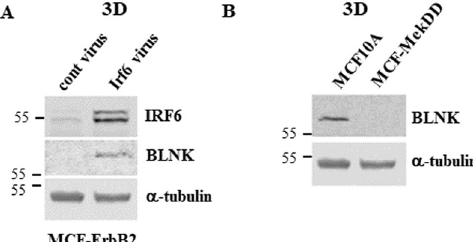
Fig. 2 Irf6 upregulates BLNK in detached ErbB2-positive breast cancer cells. A MCF-ErbB2 cells infected with the control (cont virus) or the Irf6-encoding Maloney murine leukemia virus (MMLV) (Irf6 virus) were cultured detached from the ECM for 24 h and assayed for Irf6 and BLNK levels by western blotting. α -tubulin was used as a loading control. B MCF10A cells and a variant of MCF10A cells obtained by infection of these cells with a retrovirus carrying constitutively active Mek2 mutant (MCF-MekDD) were cultured detached from the ECM for 24 h and assayed for BLNK expression as in A